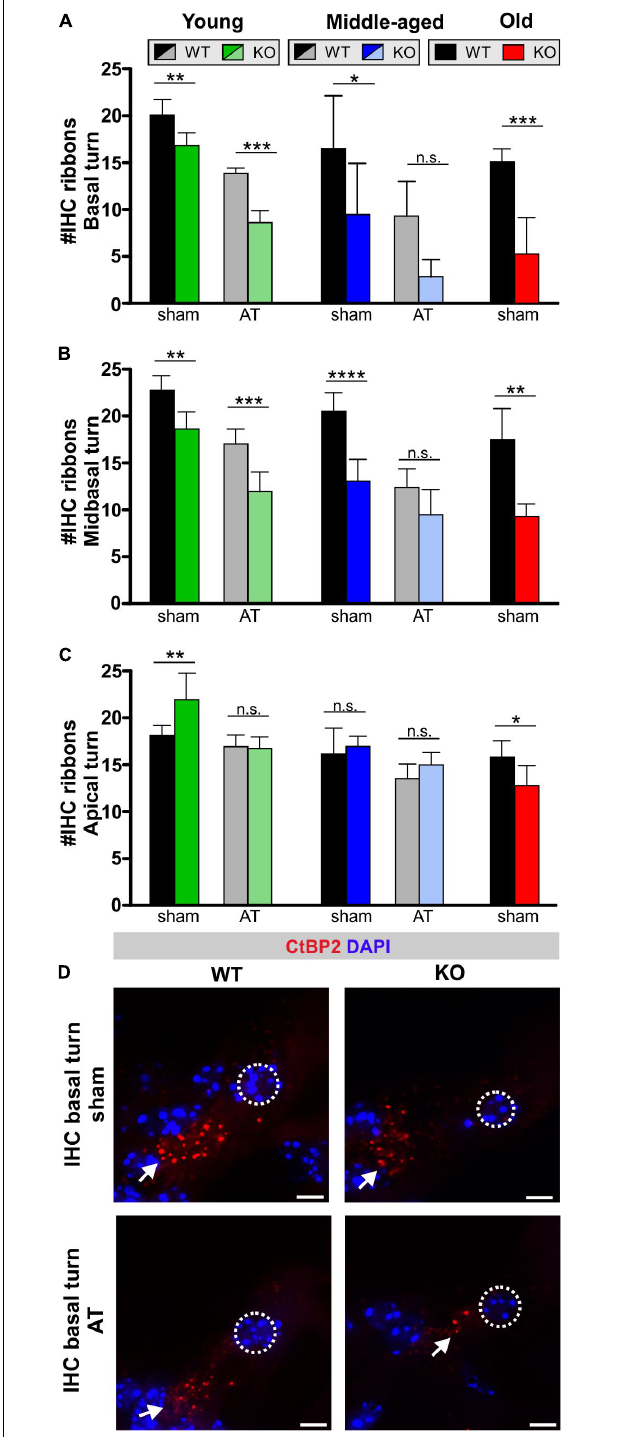
FIGURE 6 | Inner hair cell ribbons in GC-A WT and KO mice 7 days after sham treatment or acoustic trauma. (A) Ribbon-synapse numbers of IHCs in the basal cochlear turn after sham exposure and acoustic trauma [young: two-way ANOVA, Genotype: F (1,20) = 65.9, P < 0.0001; AT: F (1,20) = 185.69, P < 0.0001, post hoc test: sham WT vs. sham KO